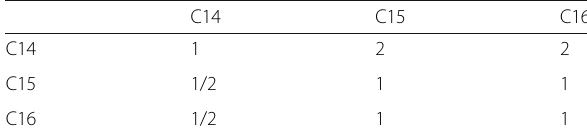
Table 13 The judgment matrix under “ Cooperation and Relationship ” . (Source: Authors)